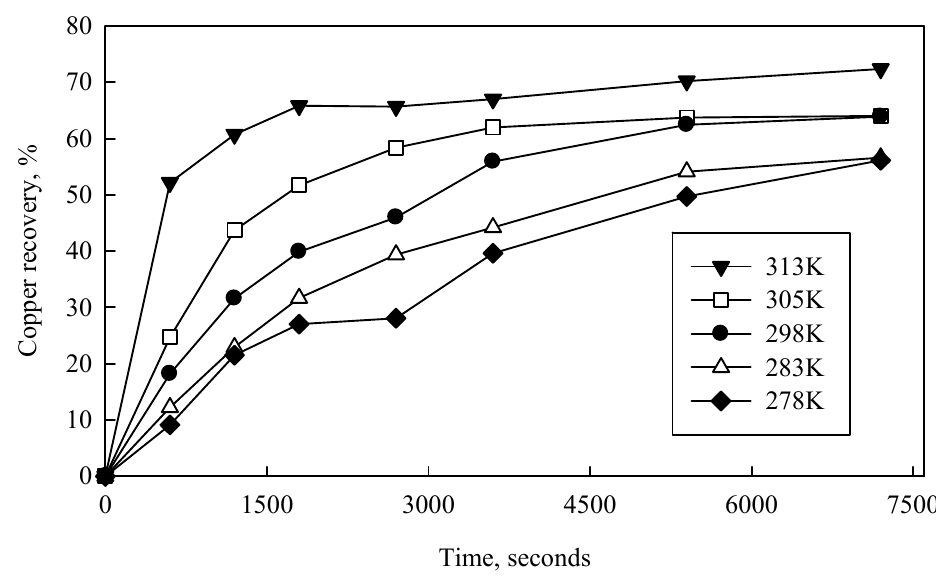
Figure 7. Analysis of the effect of temperature on the rate of malachite dissolution. Working conditions: NH 4 OH = 0.1 mol/dm 3 , pH = 10.5, particle size = 5 μ m, stirring rate = 500 rpm and S/L ratio = 1:1000.